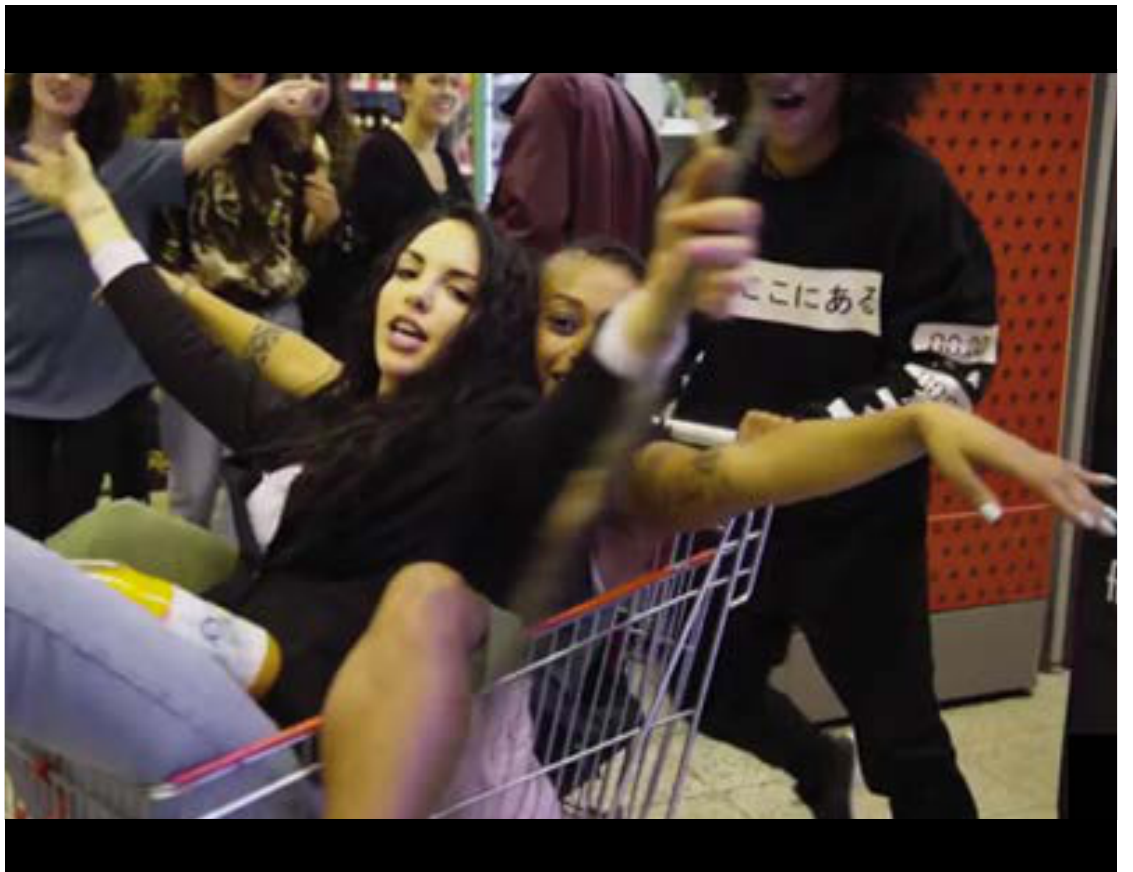
Figure 1—2 (pages 41): The Breaks by Planningtorock. Source: http://www.youtube.com/watch?v=BWO9LweKzV8 screenshot. Accessed November 30, 2019. Figure 3—4 (pages 42): Exorcise by Gazelle Twin. Source: http://www.youtube.com/watch?v=opfewQ2eab8 screenshot. Accessed November 30, 2019. Figure 5—6 (pages 43): Rub by Peaches. Source: https://vimeo.com/147527929 screenshot. Accessed November 30,